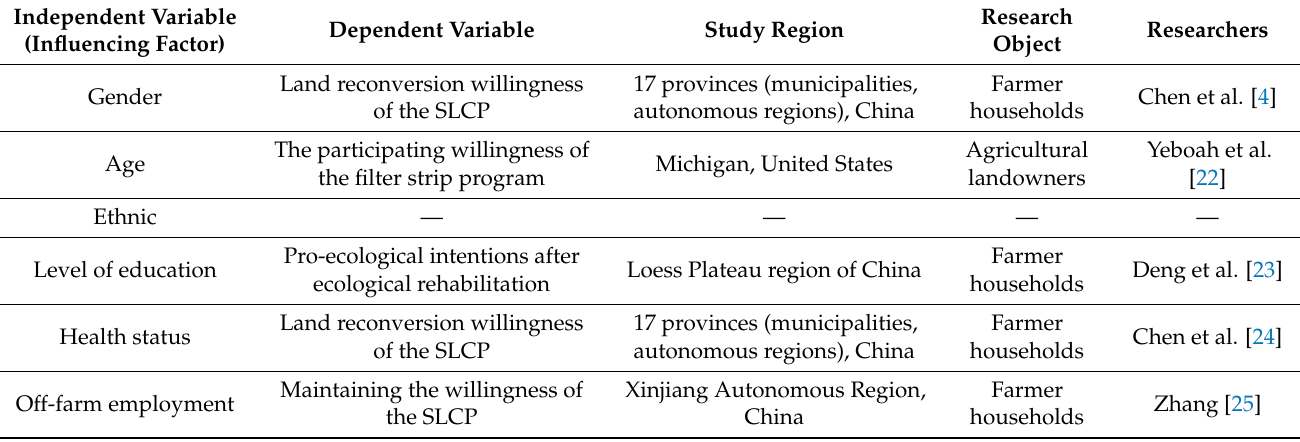
Table 1. Variable selection of farmers’ willingness to maintain the